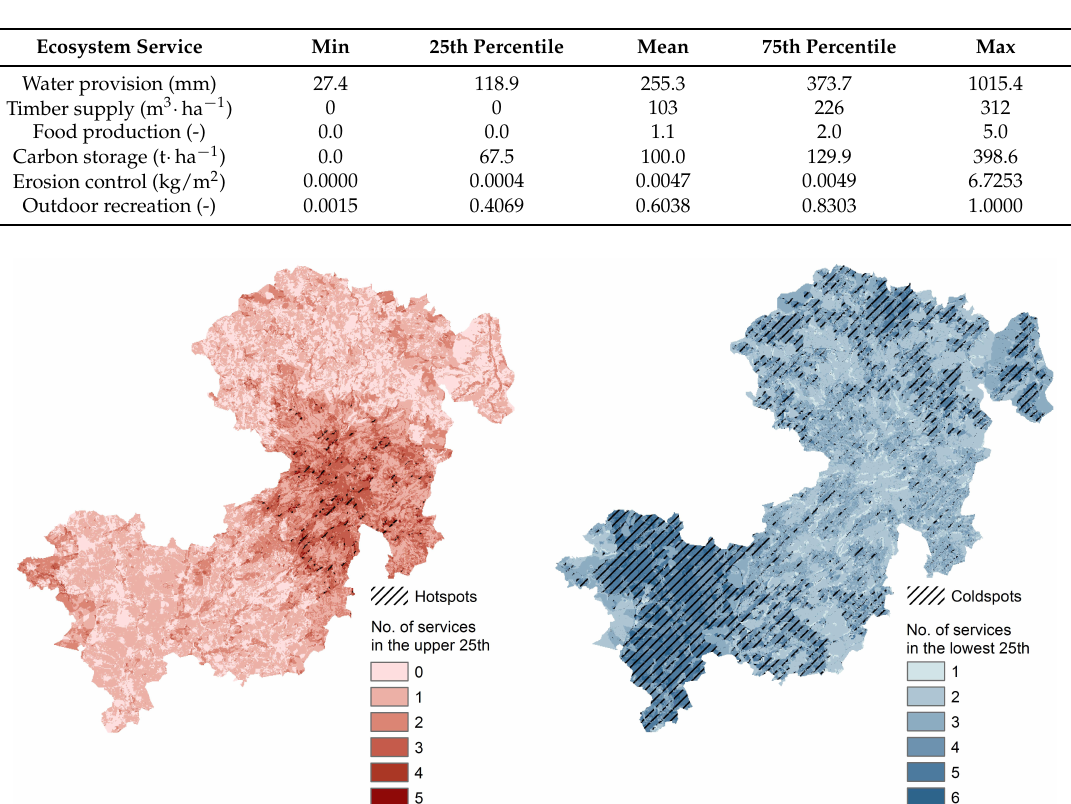
Table 2. Summary of descriptive statistics of biophysical indicators for each ecosystem service.